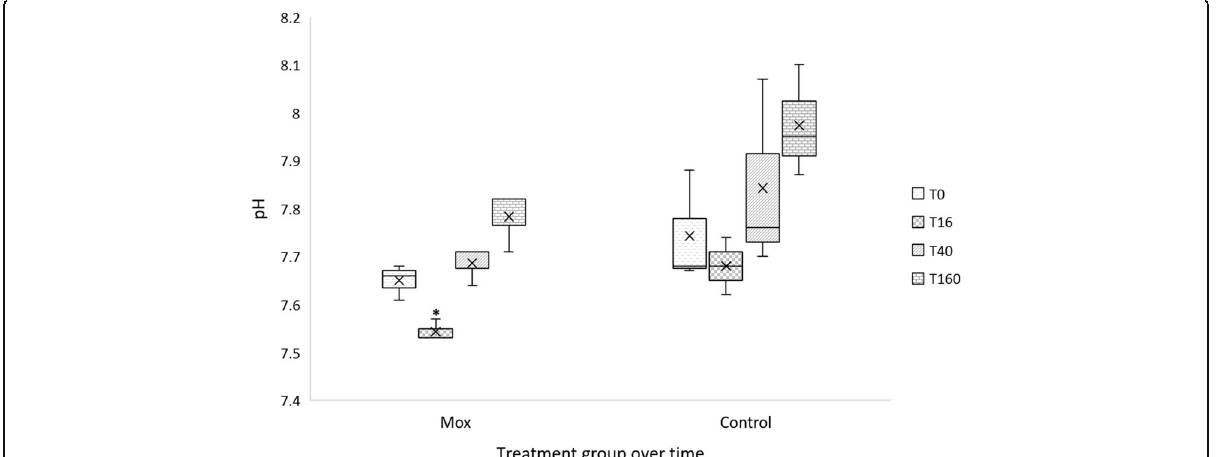
Fig. 3 The pH of the fermentation inoculum of faeces from the horses in the moxidectin and control groups over all sampling points (0 – 160 h). The pH of the fermentations were significantly lower ( p = 0.004) following inoculation with faeces from moxidectin treated horses 16 h (*) after